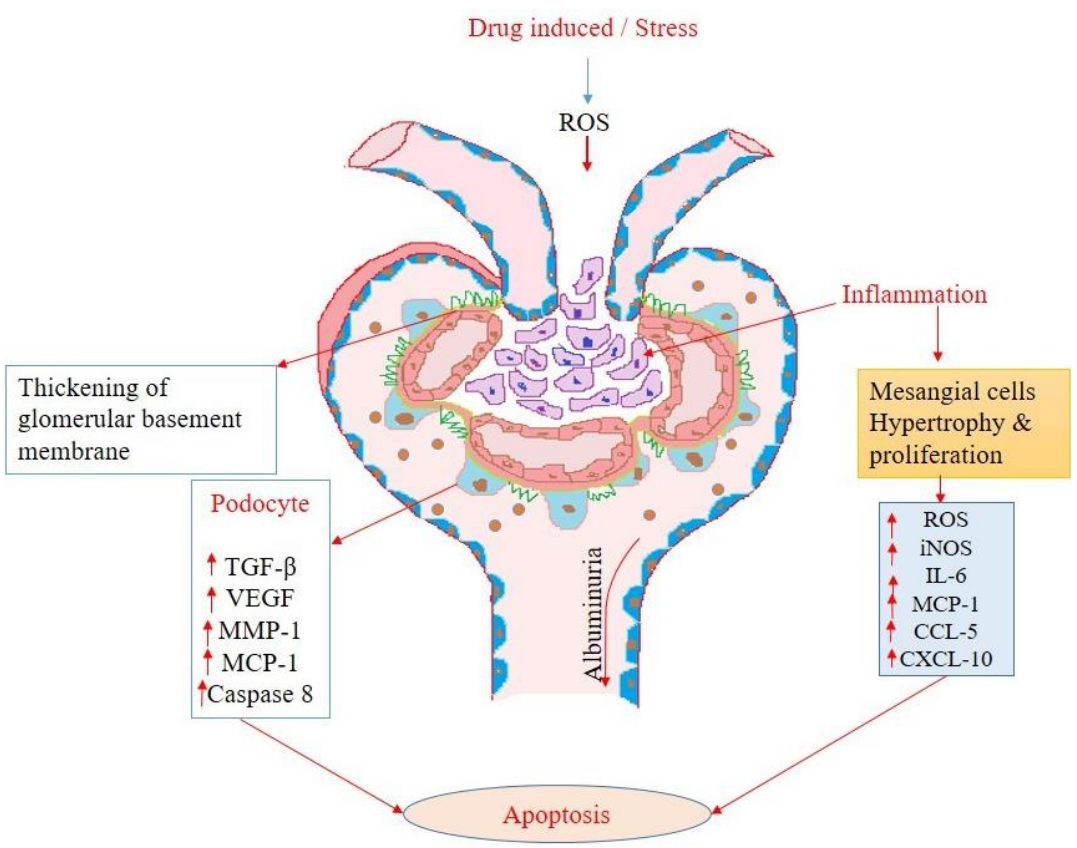
Figure 1. Glomerular structural alterations and damage results in release of several markers during the phases of acute kidney injury.